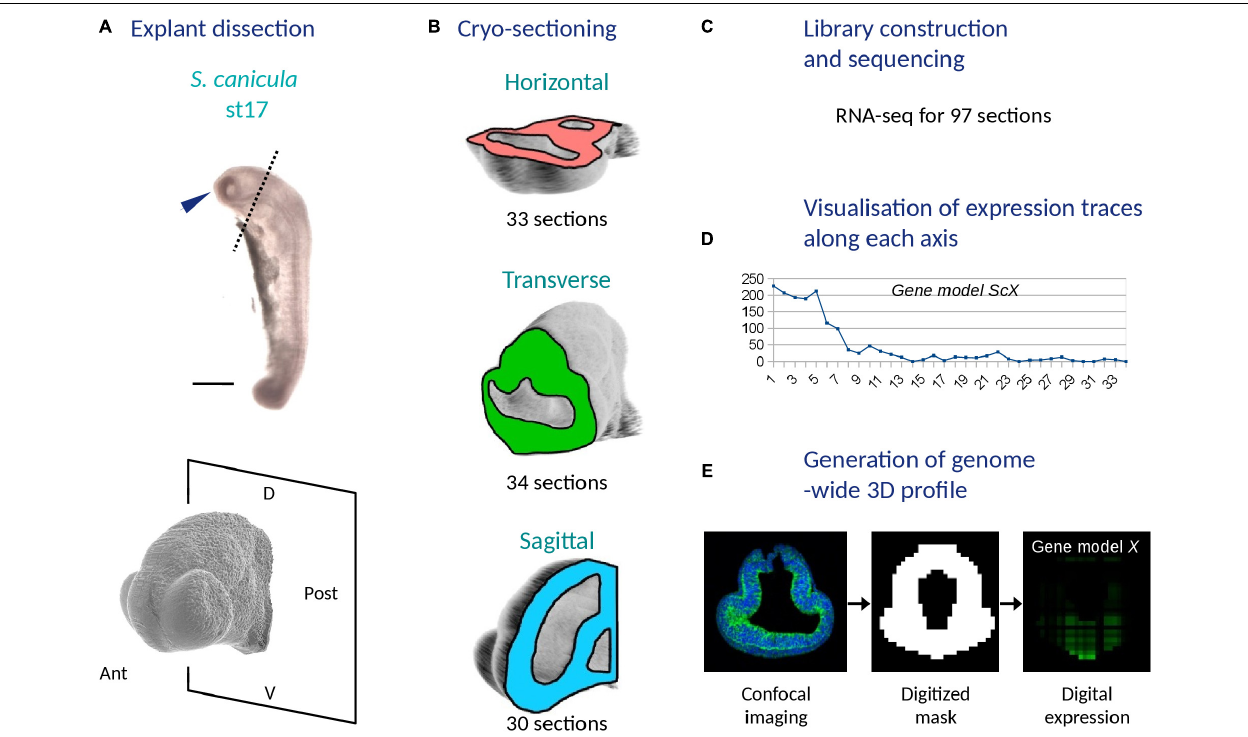
FIGURE 1 | Main experimental steps used to generate a 3D RNA profile of the catshark embryonic head (stage 17). (A) Explant dissection: the top panel shows a left side photograph of a stage 17 catshark embryo with a blue arrowhead showing the dissected explant and a dotted line delimiting its posterior boundary and the bottom panel shows a higher magnification confocal view of the explant with the posterior dissection plane. (B) Cryo-sectioning: schemes show the planes used to generate series of cryo-sections (horizontal, pink; transverse, green; sagittal, blue). The total number of sections along each plane is indicated. (C) Library construction and sequencing resulting in RNA-seq data for a total of 97 sections. (D) Visualization of expression traces along each axis for all gene models. (E) Generation of a genome-wide 3D profile with its three steps (acquisition of a confocal 3D image of the explant, generation of a digitized model and computation of digital expressions for each voxel and gene model). D, dorsal; V, ventral; Ant, anterior; Post,